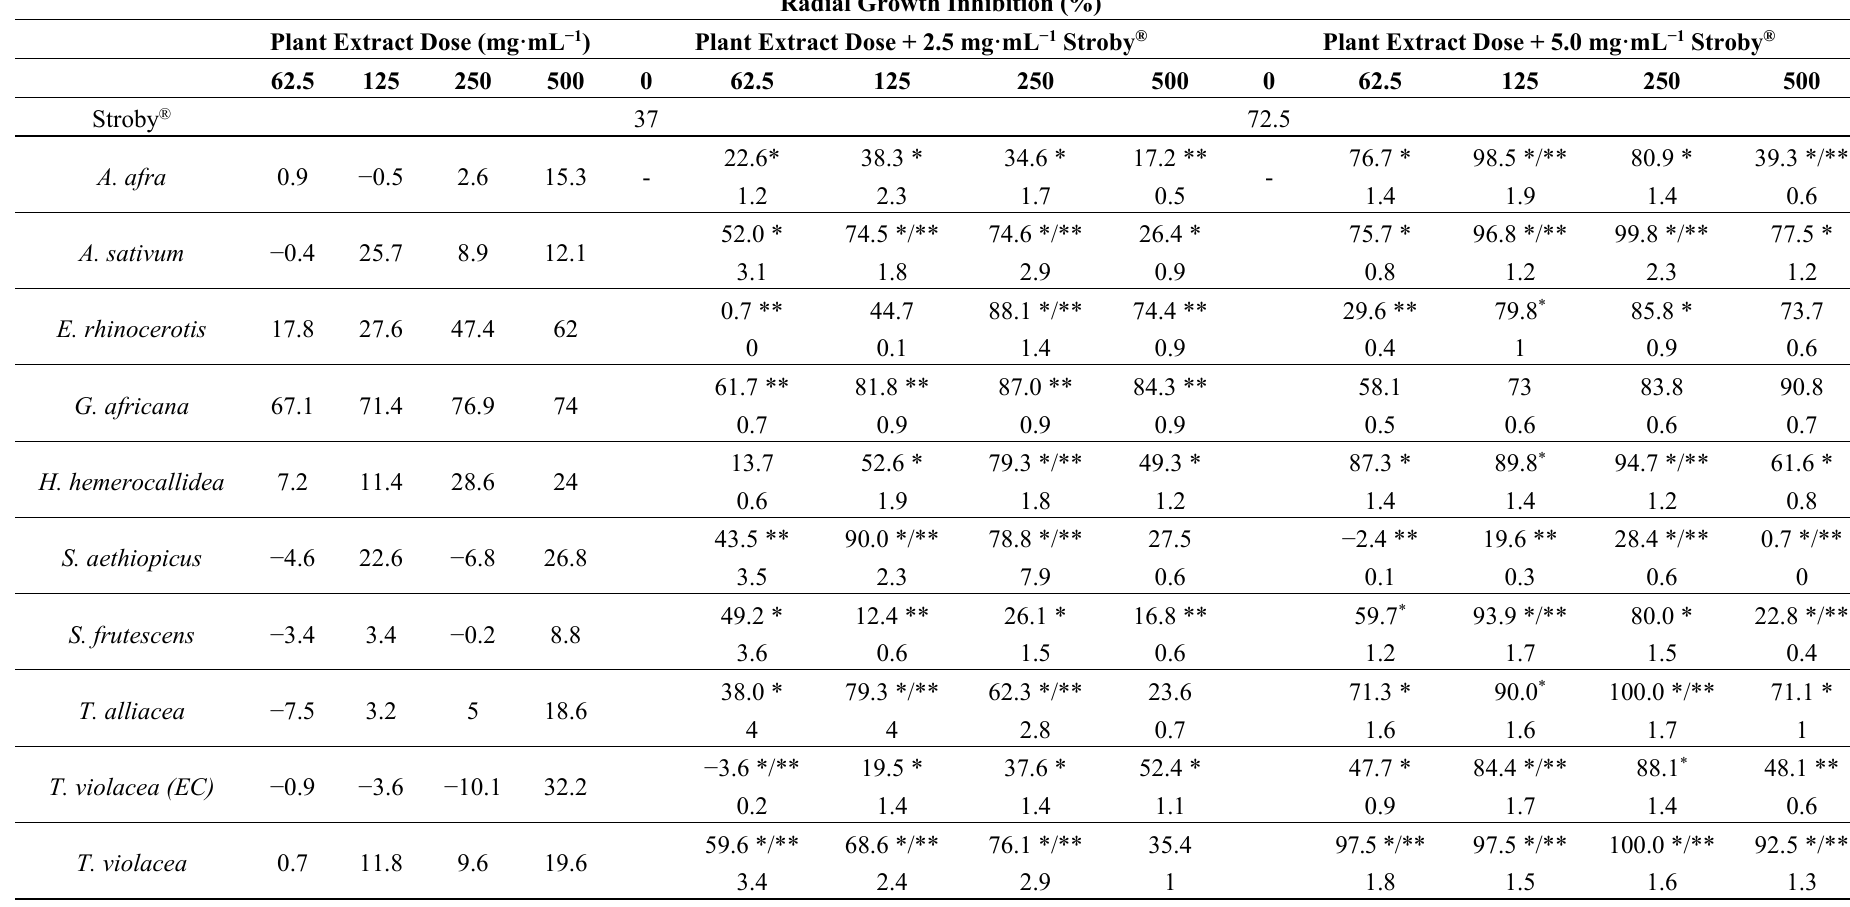
Table 1. Inhibition of radial growth and synergy ratio (SR) between the kresoxim methyl fungicide and different plant extract doses against Botrytis cinerea in vitro